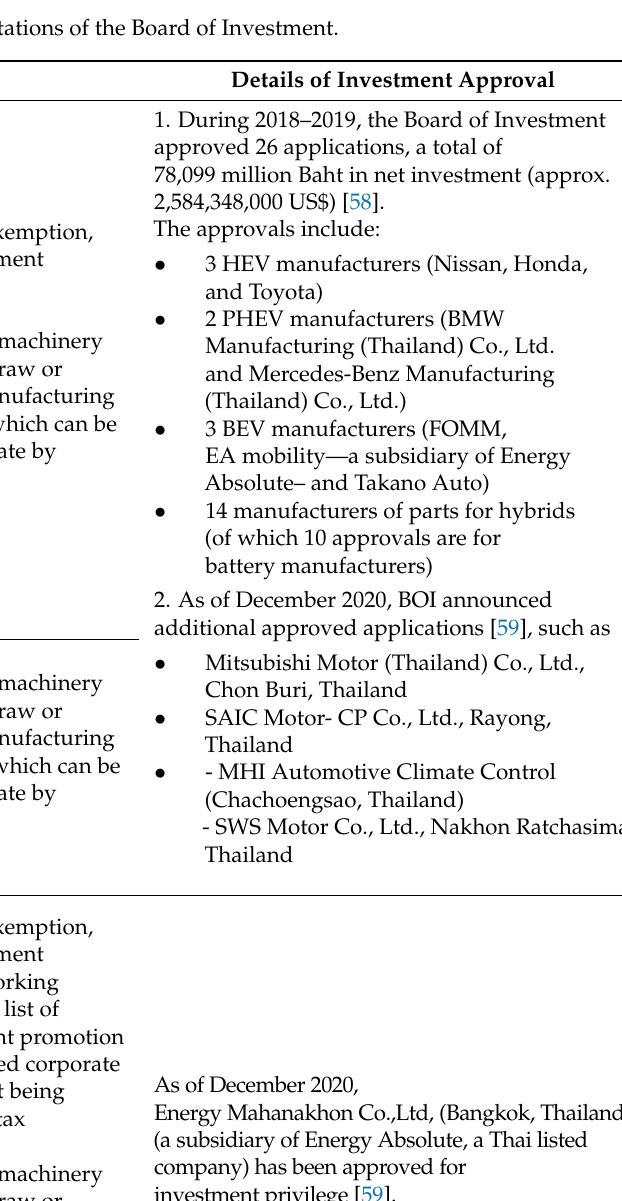
Table 1. Incentives for EV and EV stations of the Board of